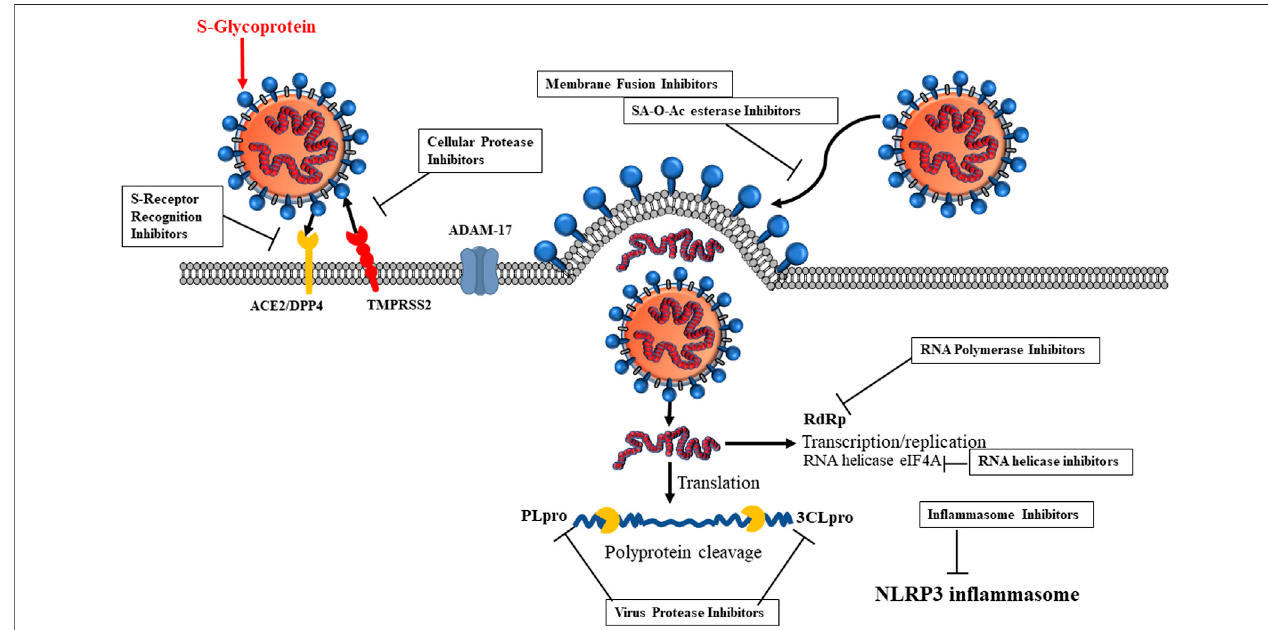
FIGURE 3 | Inhibitor candidates for SARS-CoV-2 life cycle. 1) S-glycoprotein receptor recognition, 2) cellular protease, 3) virus proteases, 4) RNA polymerase, 5) in fl ammasome, 6) RNA helicase, 7) SA-O-Ac-esterase.